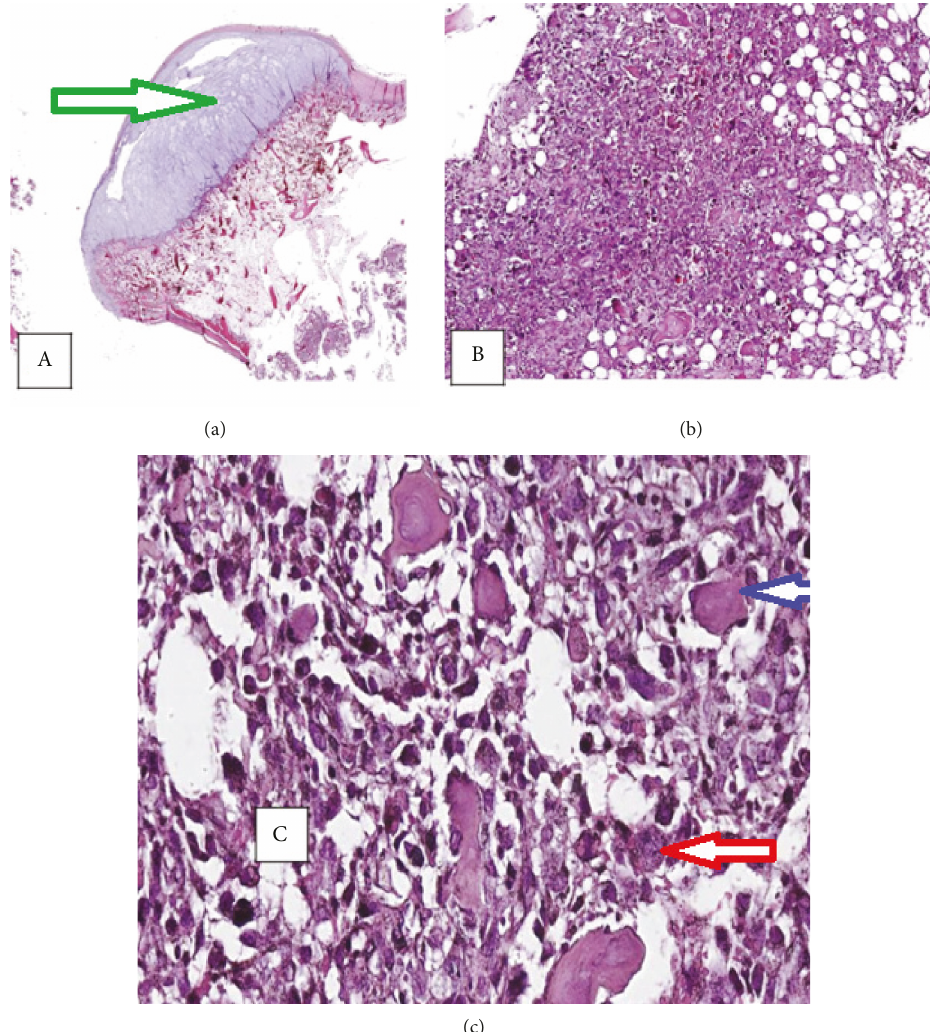
Figure 4: Photomicrographs showing (a) fi brocartilaginous cap (osteochondroma or exostosis-green arrow) (H&E × 20), (b) the tumor- forming osteoid in the marrow and numerous pleomorphic bizarre osteoblasts (H&E × 100), and (c) higher power showing spicules of new bone (osteoid) (blue arrow) among the osteoblasts (red arrow) (H&E ×